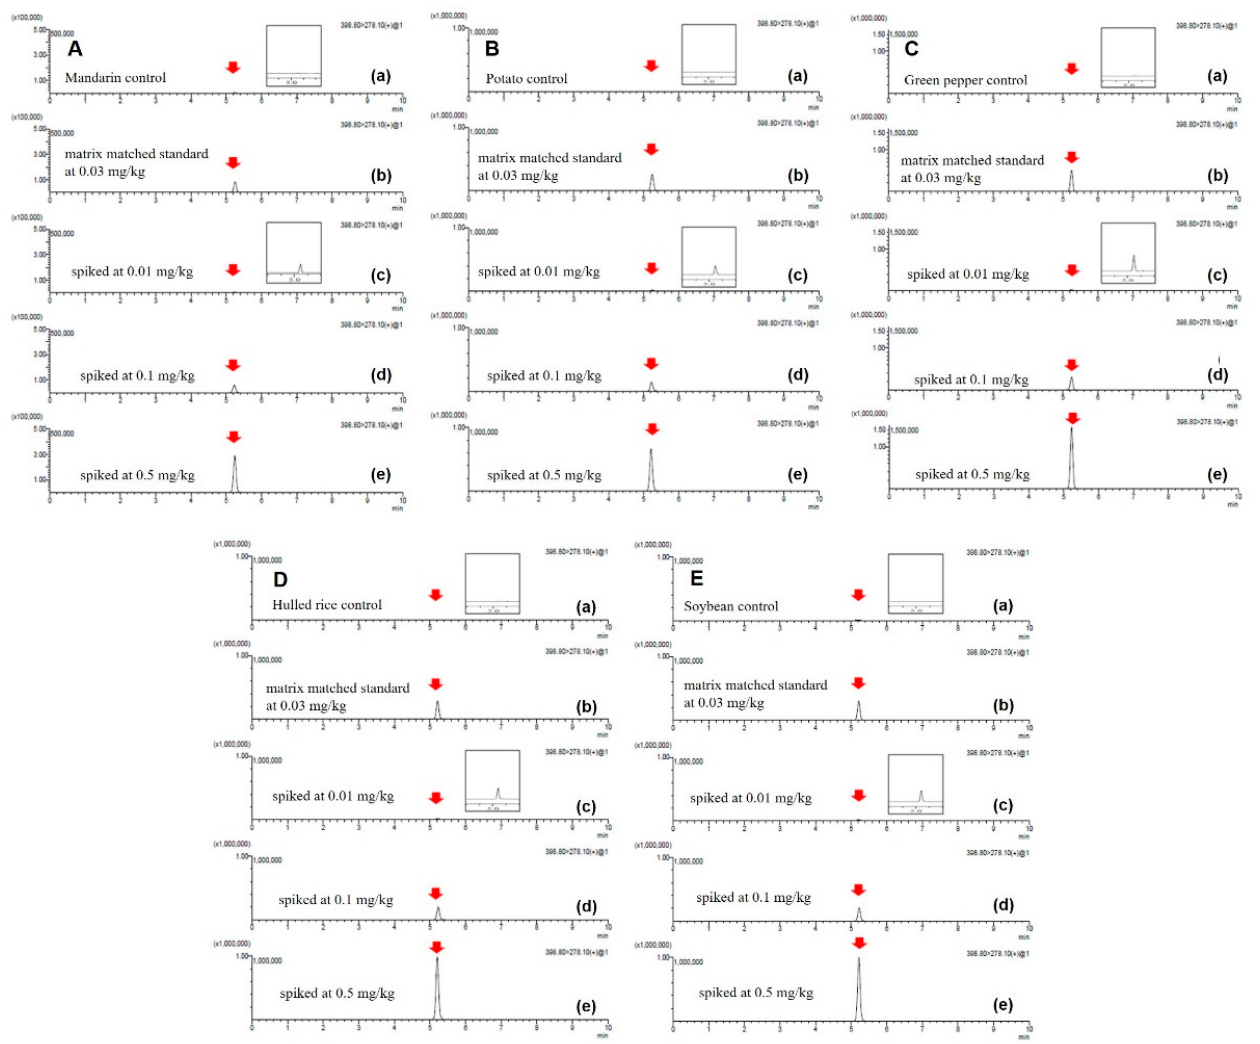
Figure 4. Inter-laboratory comparison of triflumezopyrim residue (quantification ion 399 > 278) in ( A ) mandarin, ( B ) potato, ( C ) green pepper, ( D ) hulled rice, and ( E ) soybean: ( a ) control of each food, ( b ) matrix-matched standard at 0.03 mg/kg, ( c ) spiked at 0.01 mg/kg, ( d ) spiked at 0.1 mg/kg, and ( e ) spiked at 0.5 mg/kg).